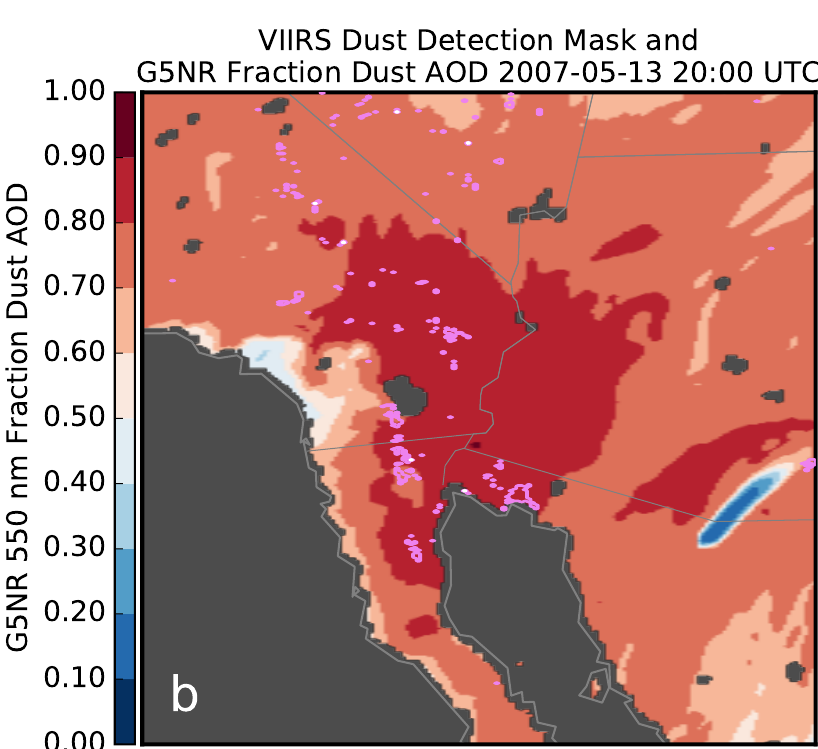
Figure 17. ( a ) Simulated 550 nm AOD, ( b ) fraction of simulated 550 nm AOD coming from dust for 13 May 2007 at 20 UTC. The purple contours represent the areas that were detected as smoke by the VIIRS aerosol detection algorithm.